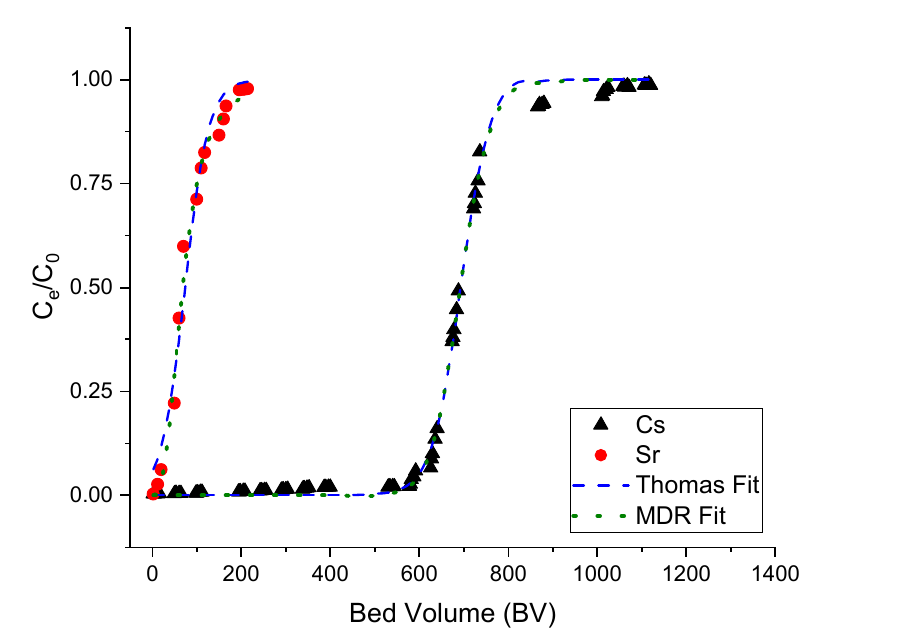
Figure 3. Static column breakthrough curve data for caesium and strontium at 200 ppm concentration and 30 min residence time, along with the Thomas and Modified Dose Response (MDR) model fits. Table 1. Fitted Thomas and Modified Dose Response (MDR) model parameters for 6 cm-depth static column breakthrough tests with Cs + and Sr 2+ .